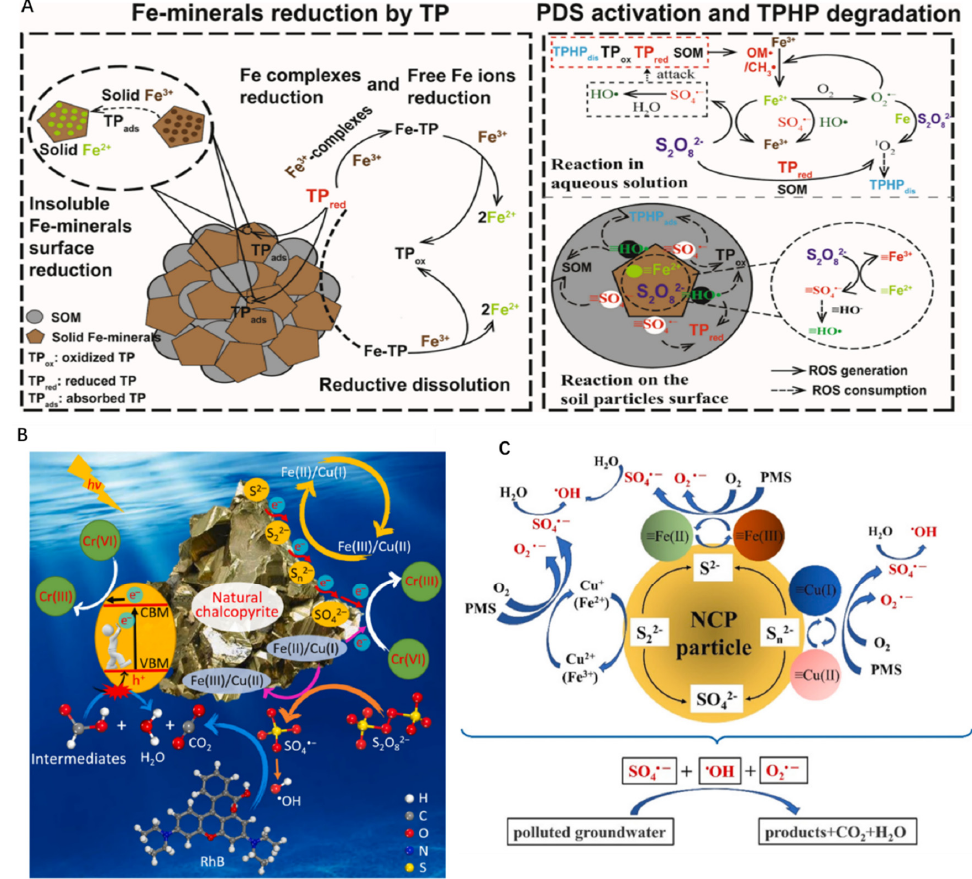
Figure 5. ( A ) The process of Fe-minerals reduction and the generation of ROS, copyright 2022 Elsevier B.V. ( B ) The mechanism of free radical production from persulfate system activated by natural minerals, copyright 2021 Elsevier B.V. ( C ) Schematic diagram for the activation mechanism of PMS by natural chalcopyrite, copyright 2021 Elsevier B.V. All.